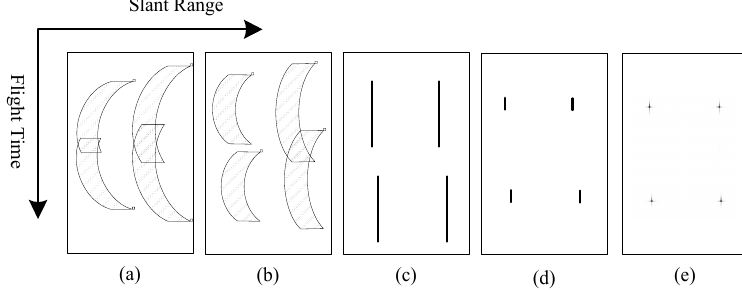
Figure 9. Conceptual basis for the proposed squint mode GEO SAR imaging algorithm. The echo signals after bulk range walk correction are demonstrated as subfigure ( a ). Then first-order filtering is applied, and the results are presented as ( b ). RCMC and other range operations together make the signals into ( c ). Partial dechirp and relevant operations shorten the azimuth span, which is shown in ( d ). Lastly, azimuth compensation produces the final images ( e